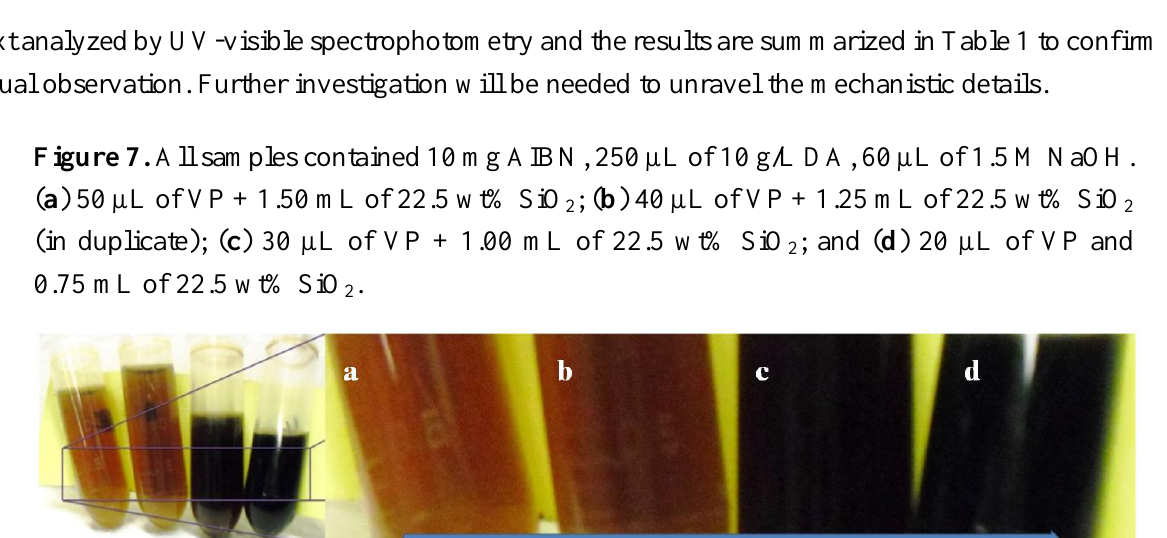
Table 1. UV-visible spectrophotometric analysis of four samples containing different concentrations of SiO and vinyl-2-pyrrolidone (VP) (albeit at a constant mole ratio of 1:1) 2 but the same amounts of azobisisobutyronitrile (AIBN) (10 mg), DA (250 µL of 10 g/L) and NaOH (60 µL of 1.5 M). Wavelength of maximum Sample components absorbance